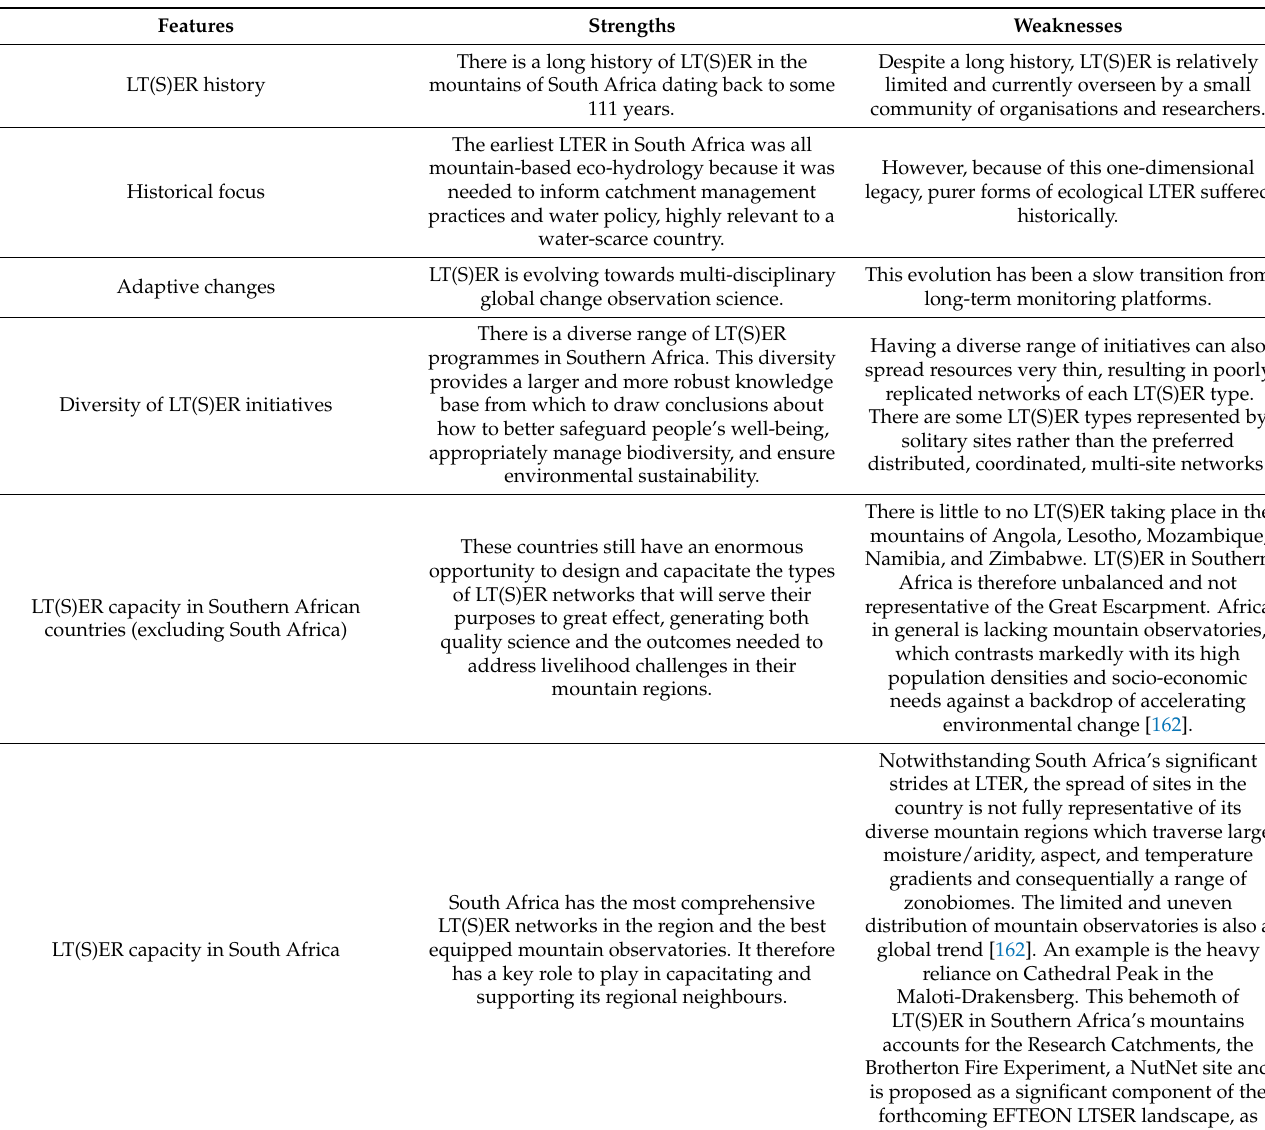
Table 1. Strengths and weaknesses of Southern Africa’s mountain observatory networks and LT(S)ER, as identified in this